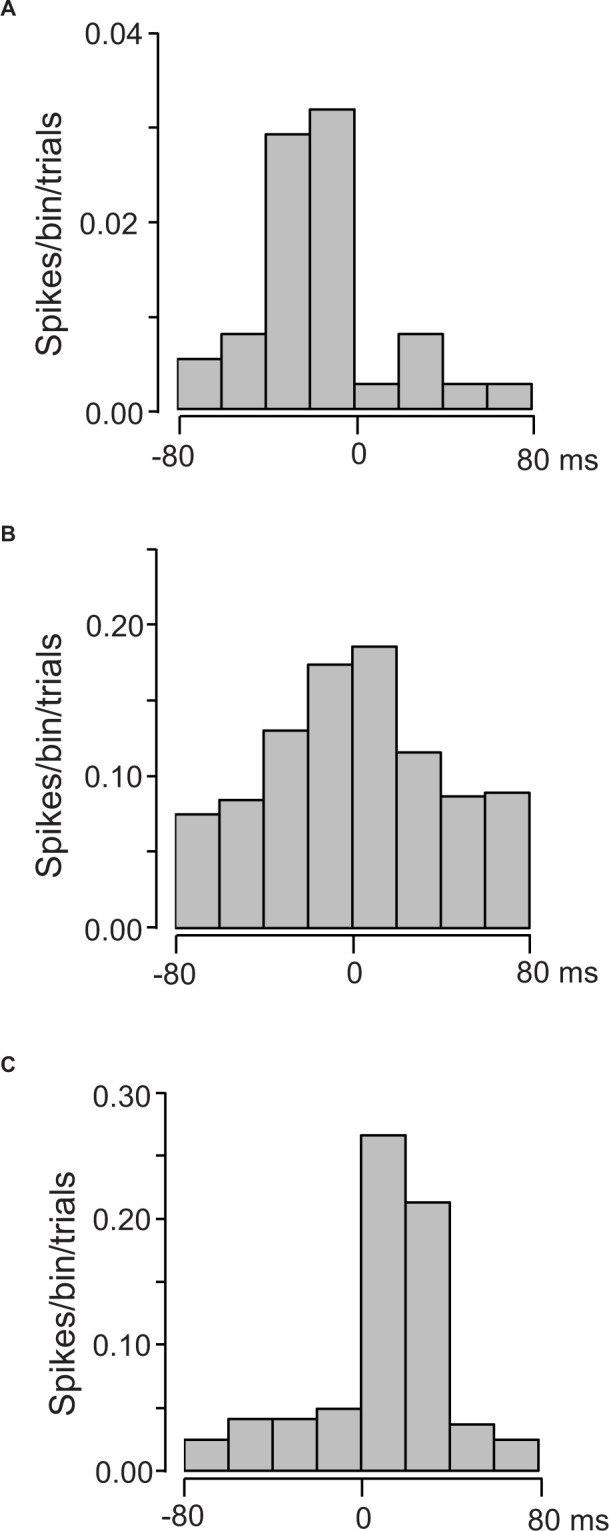
Three examples of cross-correlograms between the activity of US-responsive neurons and individual licking. (A) A US-responsive neuron with a peak before lick contact on the tube (MI = 0.21175, p < 0.0001). (B) A US-responsive neuron with a peak around lick contact on the tube (MI = 0.023186, p < 0.0001). (C) A US-responsive neuron with a peak after lick contact on the tube (MI = 0.021035, p < 0.0001). Zero on time scale indicates tongue contact with the tube. Bin width = 20 ms.